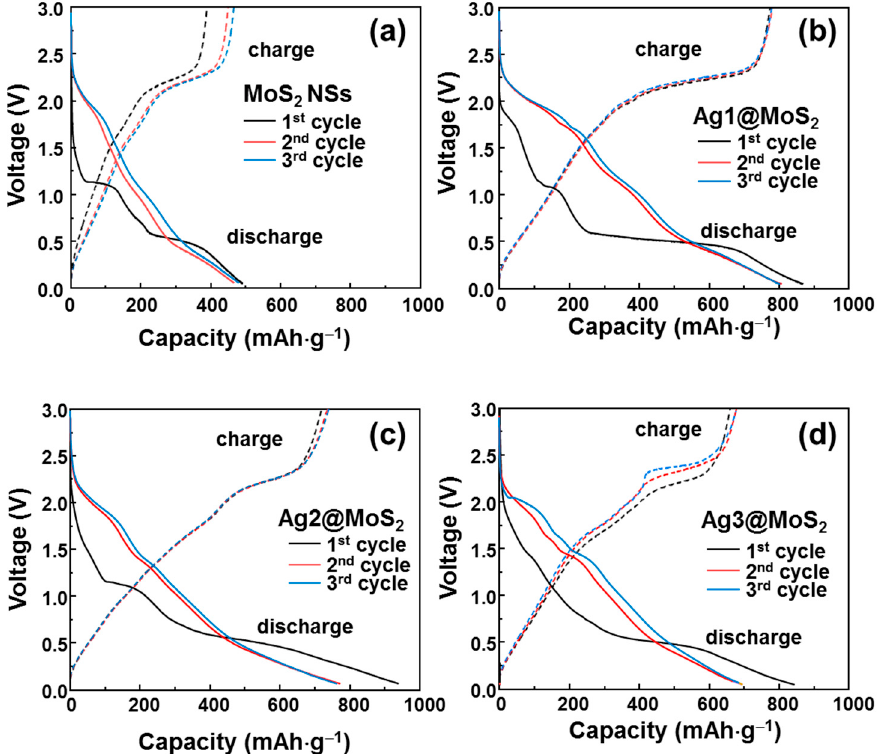
Figure 5. Initial voltage profiles of ( a ) MoS 2 NSs, ( b ) Ag1@MoS 2 , ( c ) Ag2@MoS 2, and ( d ) Ag3@MoS 2 anodes.